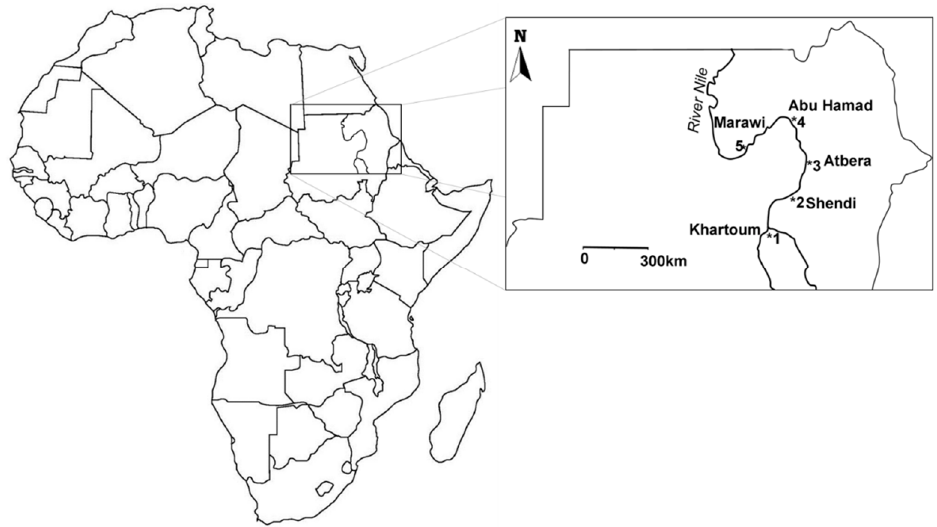
Figure 1. Map with the sampling sites of both A. florea and A. mellifera along the river Nile. Since we found no A. mellifera colonies at location 3, we collected drones at a local drone congregation area with a William’s trap. We found no A. mellifera bees at location 4, neither colonies nor drones.